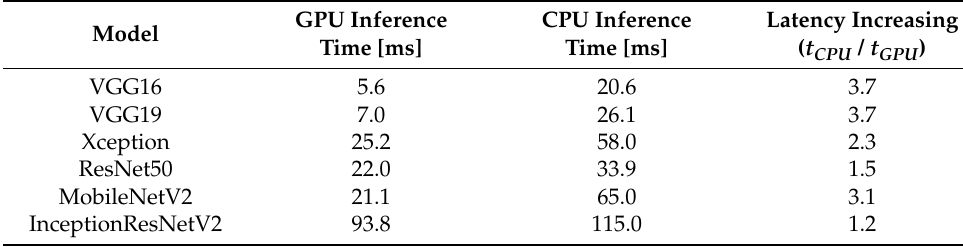
Figure 14. Images that were misclassified by the best VGG16 model. Table 3. Inference time for a single